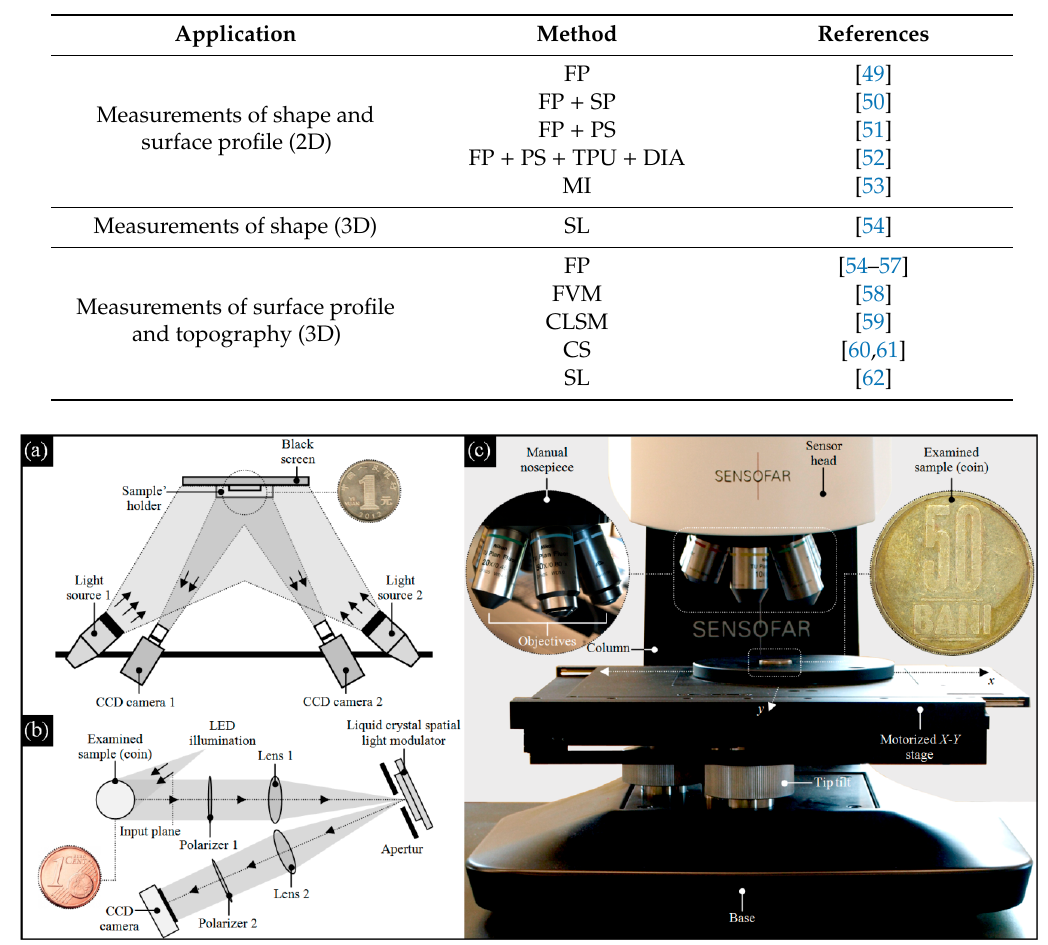
Figure 2. Selected experimental setups used for analyzing modern coins: ( a ) three-dimensional digital image correlation (3D-DIC), presented in the work Yan et al. [63] (1 yuan coin); ( b ) computational shear interferometry (CSI), shown in the work of Falldorf et al. [64] (1 euro cent coin); ( c ) confocal laser scanning microscopy (CLSM) (50 bani coin).